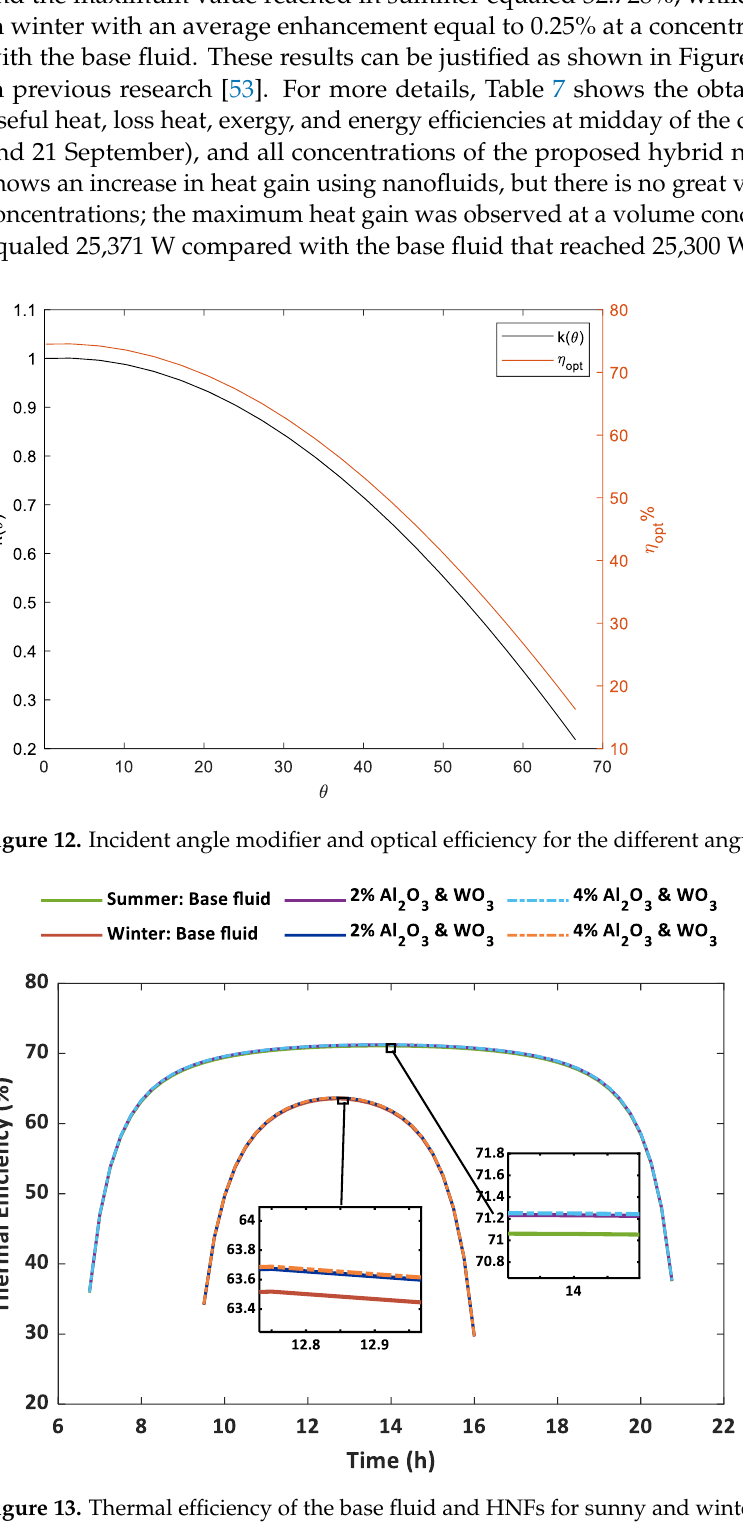
Figure 14. Exergy efficiency of the base fluid and HNFs for sunny and winter days in Budapest. Table 7. Major found results. Therminol VP1